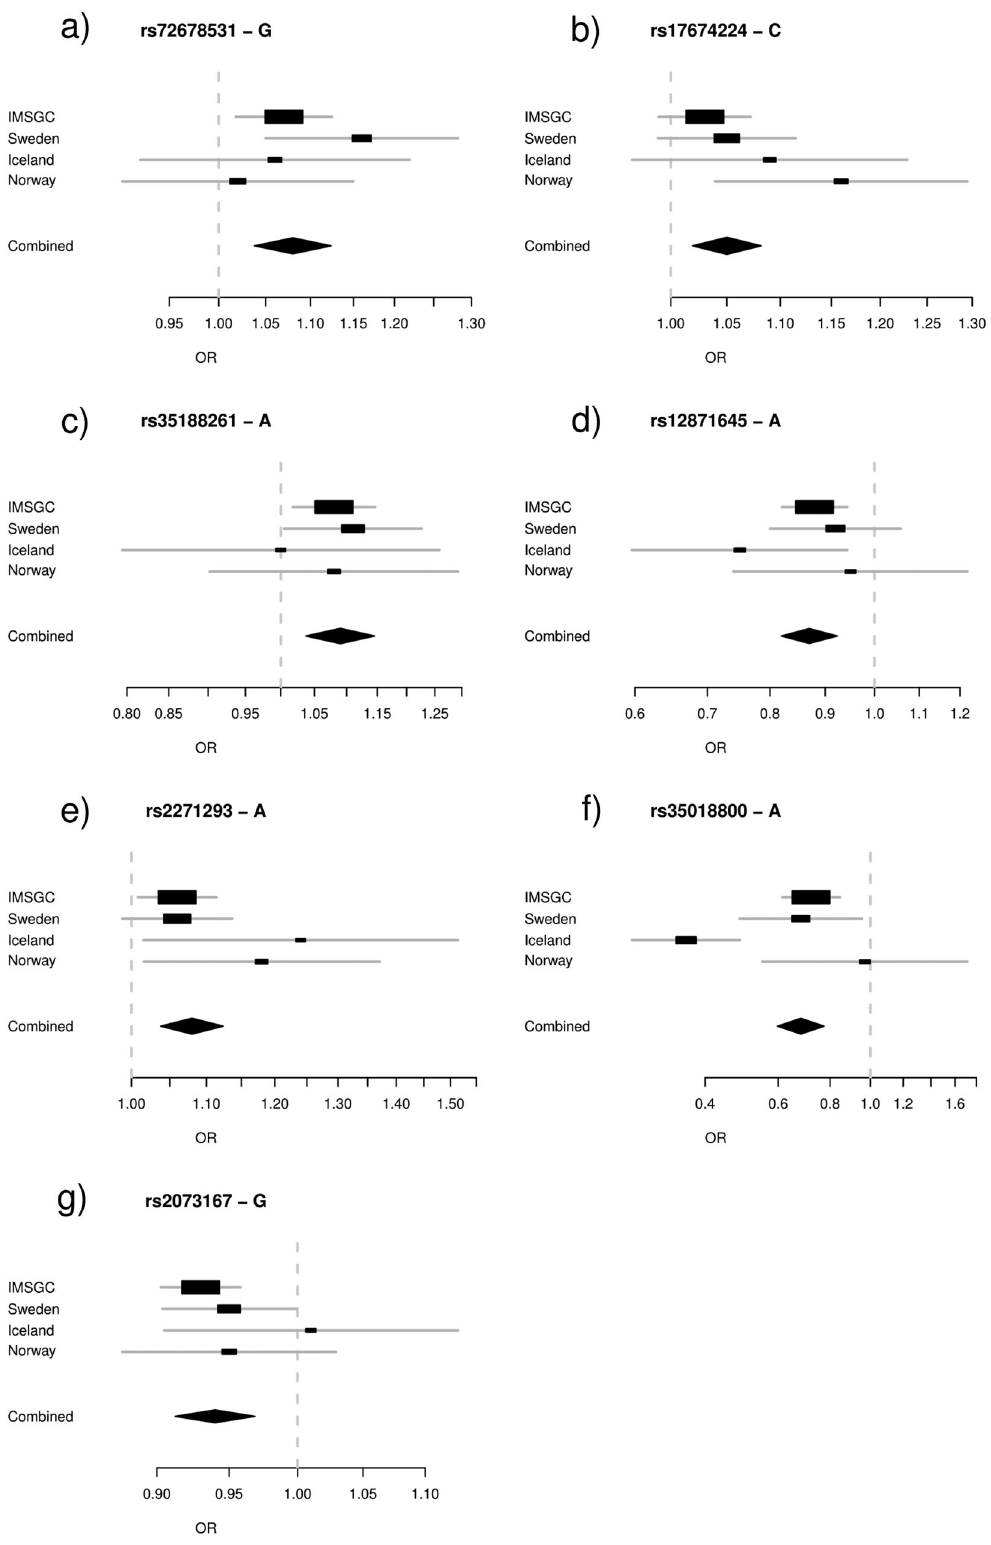
Fig. 4 Forest plots for MS variants discovered through the proxy-phenotype method. a rs72678531; b rs17674224; c rs35188261; d rs12871645; e rs2271293; f rs35018800; g